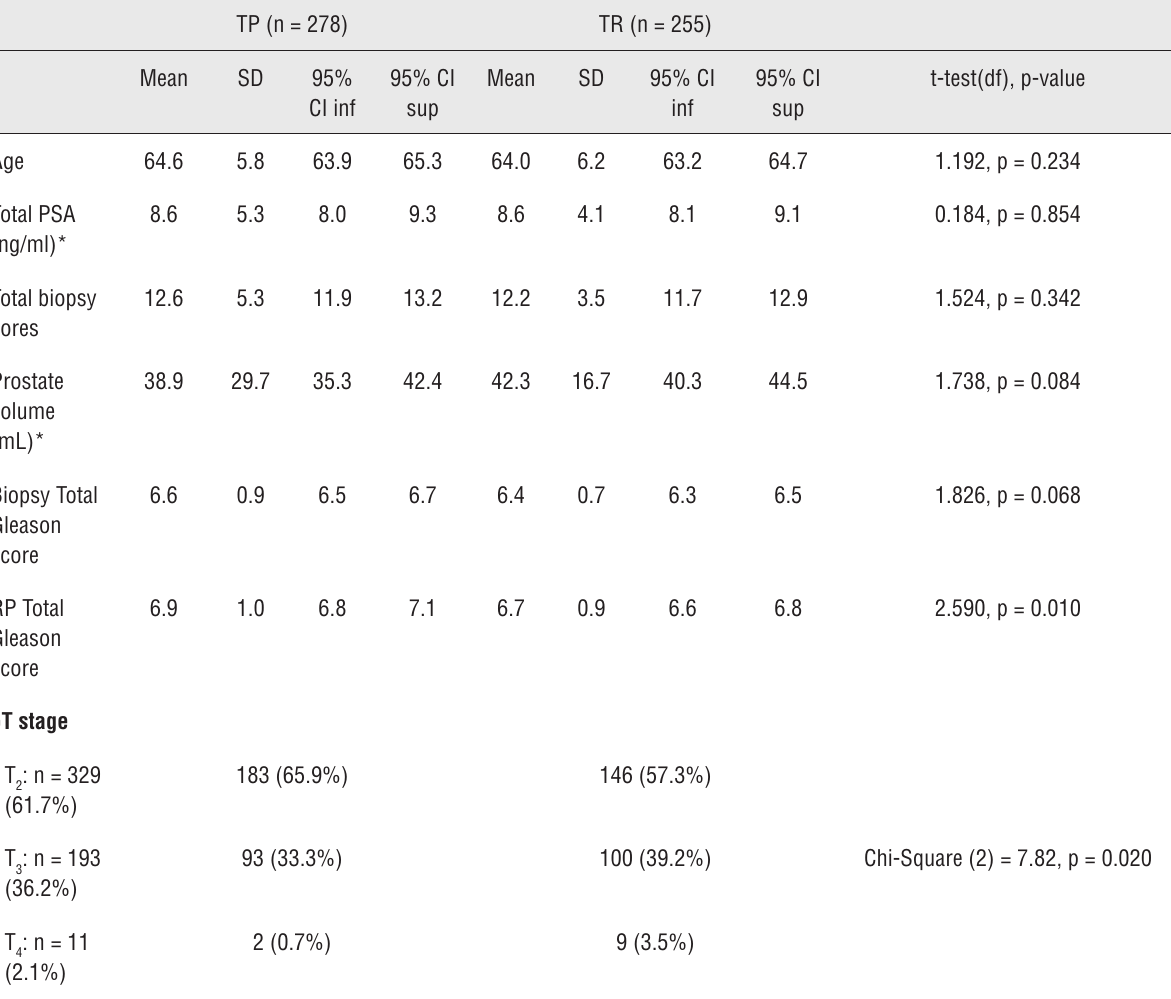
Table 1 - Baseline characteristics of the two groups (TP and TR) of patients.